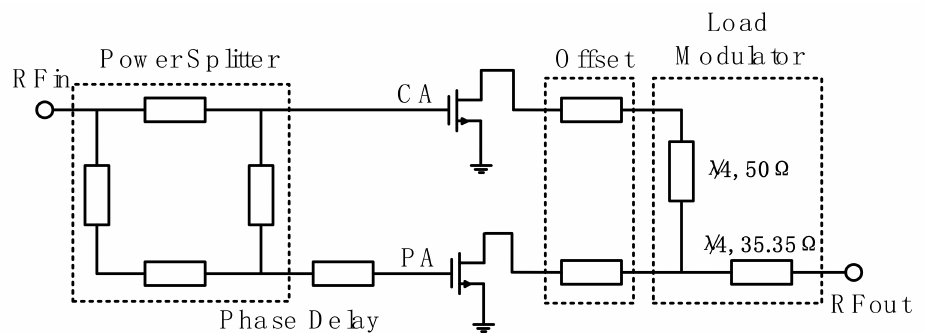
Figure 22. Doherty PA circuit schematic